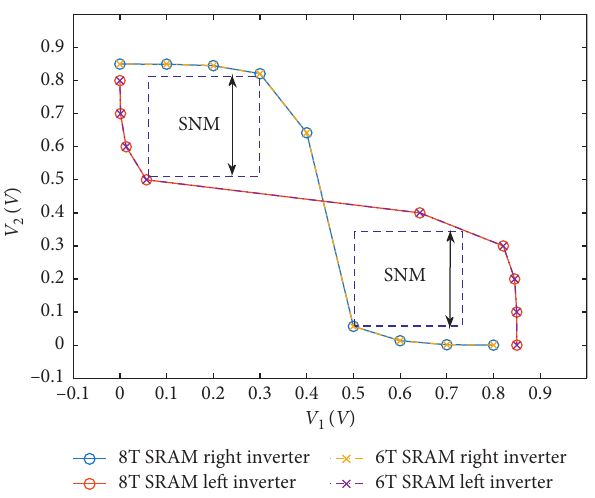
Figure 7: Butterfly curve of GNRFET-based 6Tand 8T SRAM cells in the retention